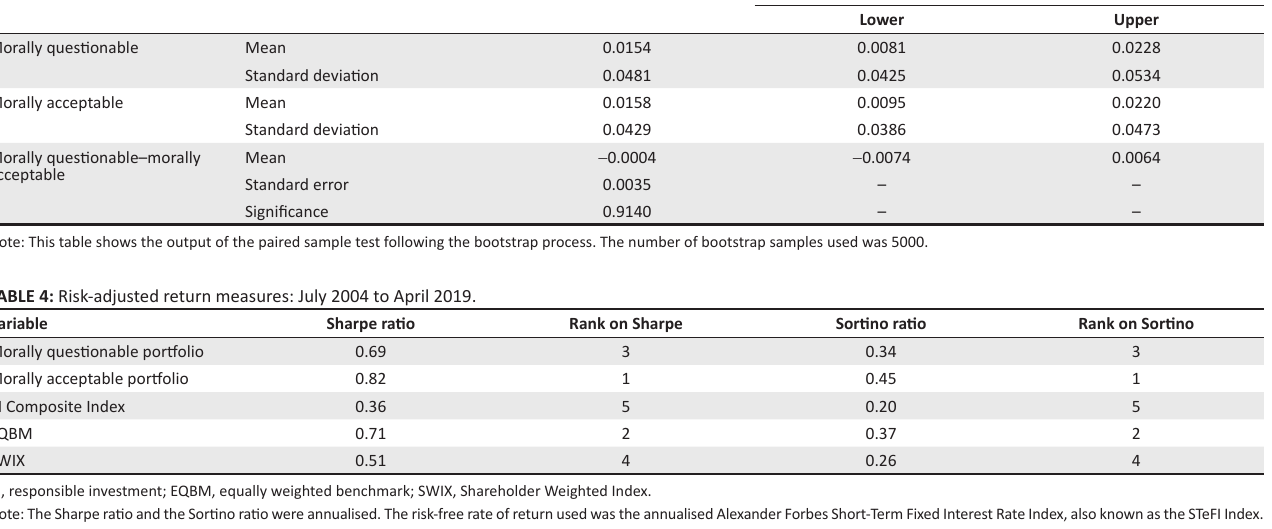
TABLE 3: Paired sample statistics.